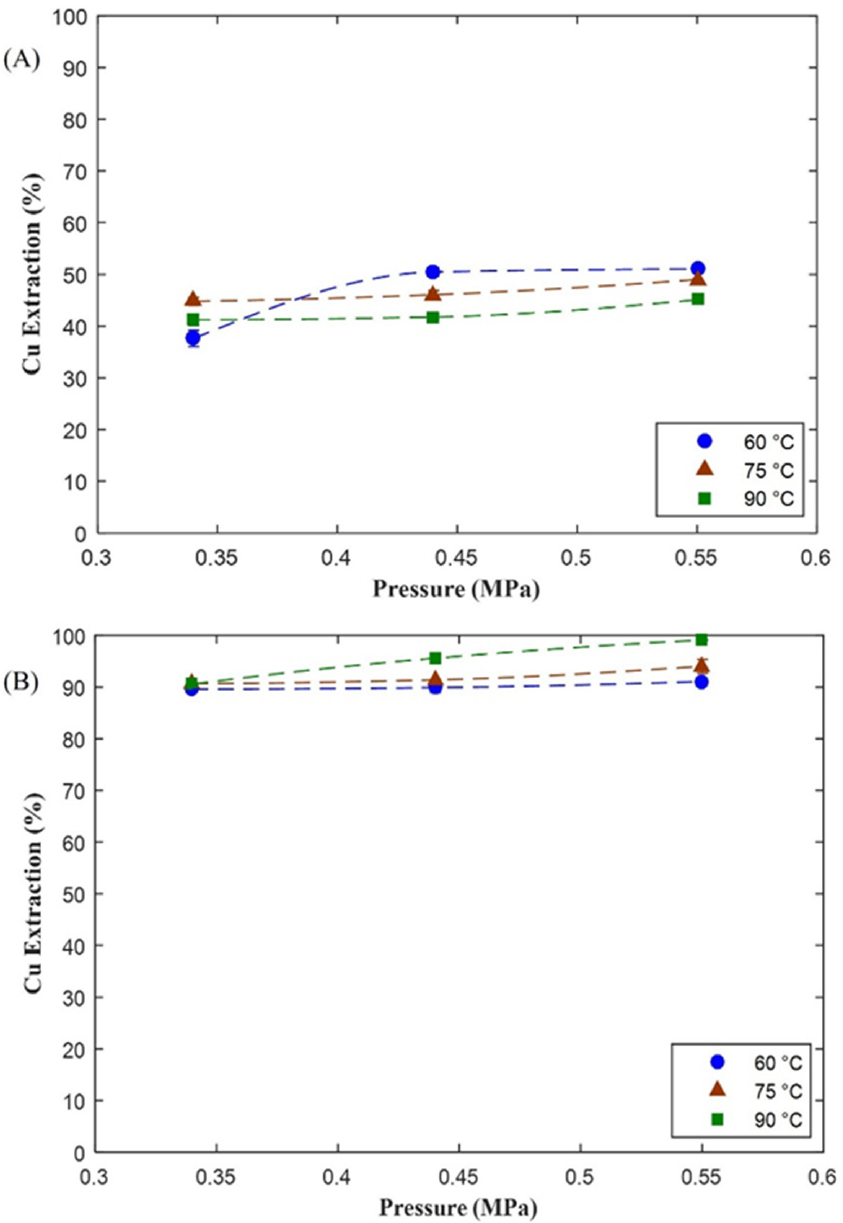
Figure 2. Cu extraction (%) as a function of pressure (MPa) at different temperatures (°C): ( A ) at 1 M H 2 SO 4 ; ( B ) at 2 M H 2 SO 4 (stirring at 600 rpm, for 4 h, 20% solids, and a particle size of − 177 μ m). 3.1.2. Zinc